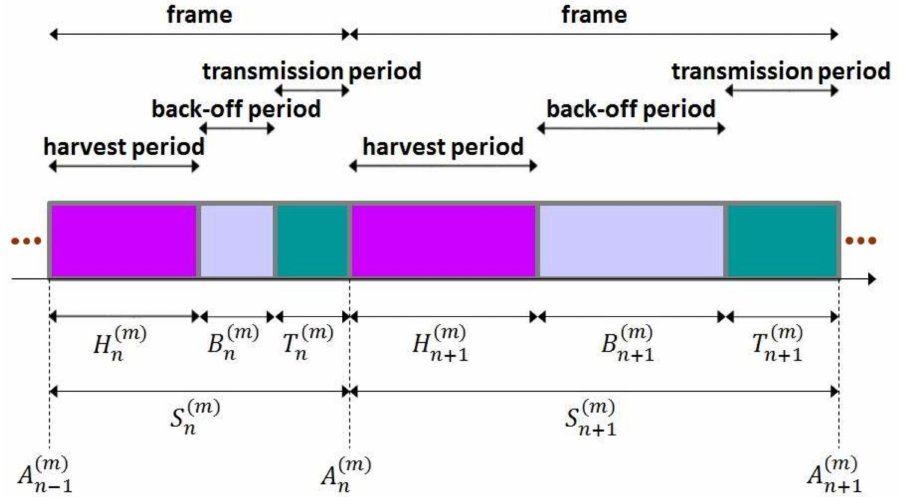
Figure 4. Harvest times, back-o ff times and transmission